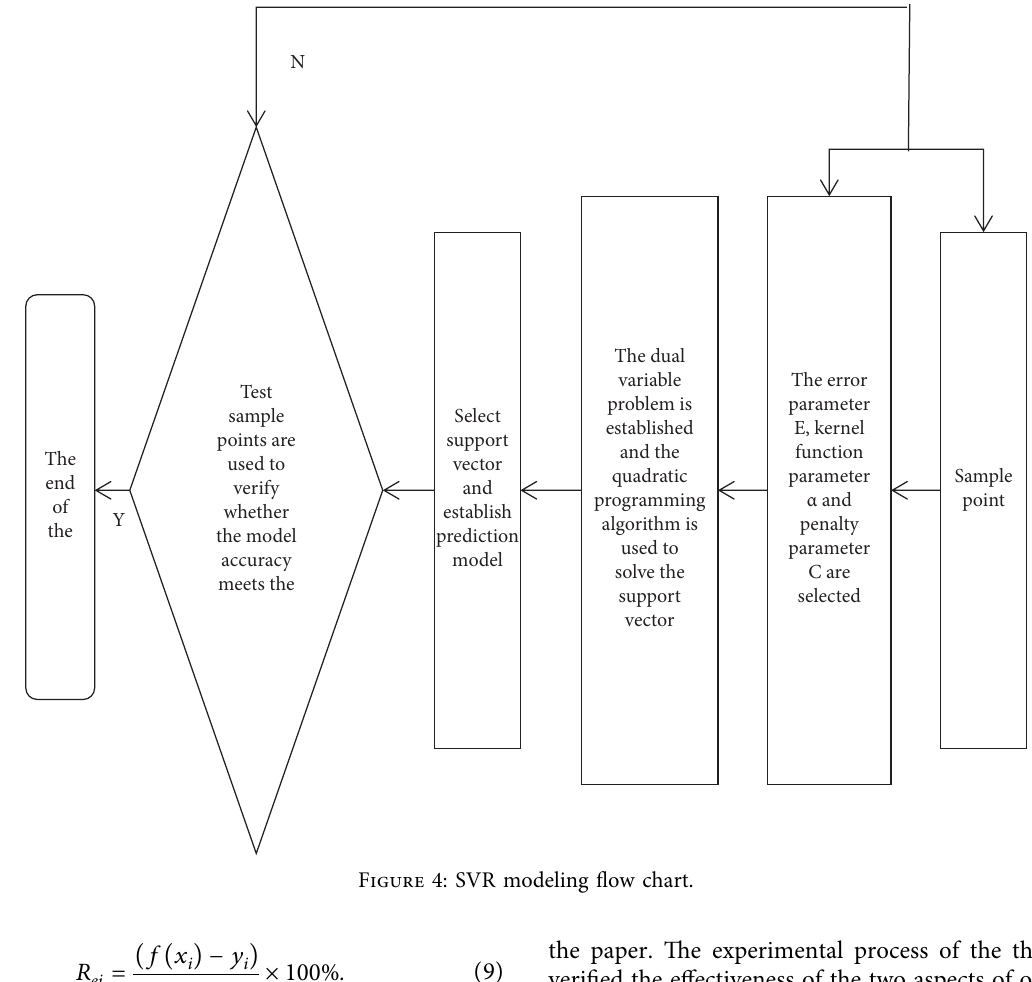
Figure 4: SVR modeling flow